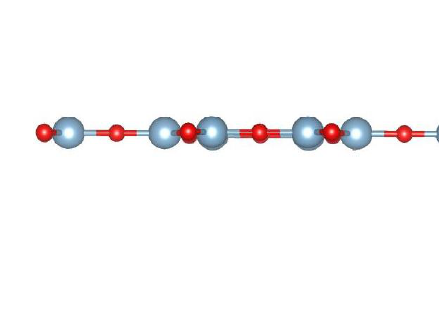
-Al O and b) PH 3 2 3